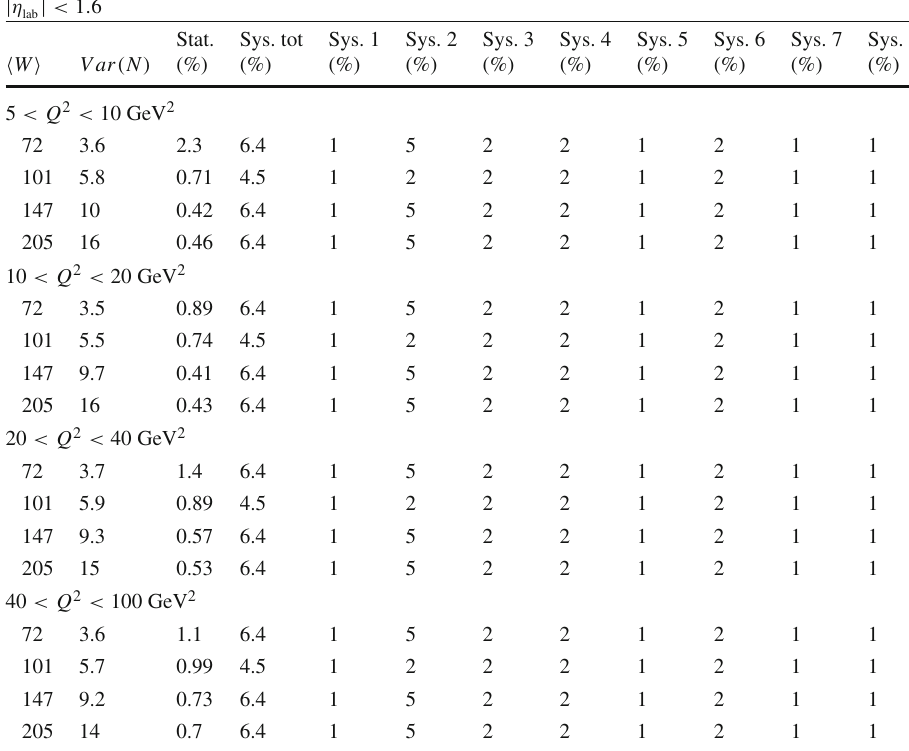
Variance of multiplicity distributions in DIS | η | < 1 . lab